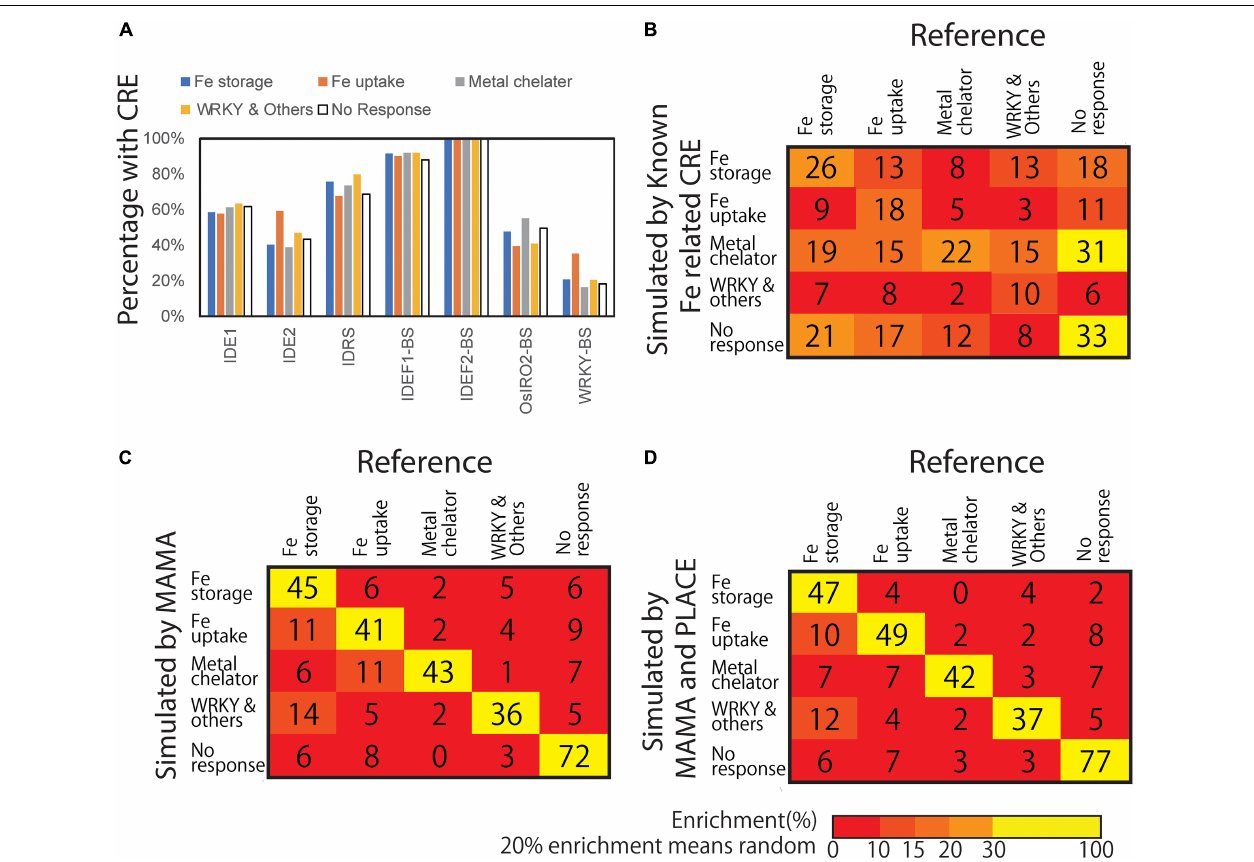
FIGURE 3 | Presence of known CREs and the confusion matrix of gene expression models based on presence and absence of CREs. (A) Presence of known Fe-related CREs. Each CRE sequence was searched from 500 bp upstream of the transcription start site (TSS) of each gene included in the Fe response groups. (B) Confusion matrix from the gene expression pattern simulation model based on the presence of known Fe-related CREs. (C) Confusion matrix of gene expression pattern simulation model based on the presence of MAMA-extracted motifs. (D) Confusion matrix of gene expression pattern simulation model based on the presence of MAMA-extracted motifs and CREs recorded in PLACE. Numbers shows the number classified by the model. Color shows Enrichment (%). A total of 20% enrichment equals to random and meaningless model. The higher the diagonal values of the confusion matrix the better, indicating accurate predictions.